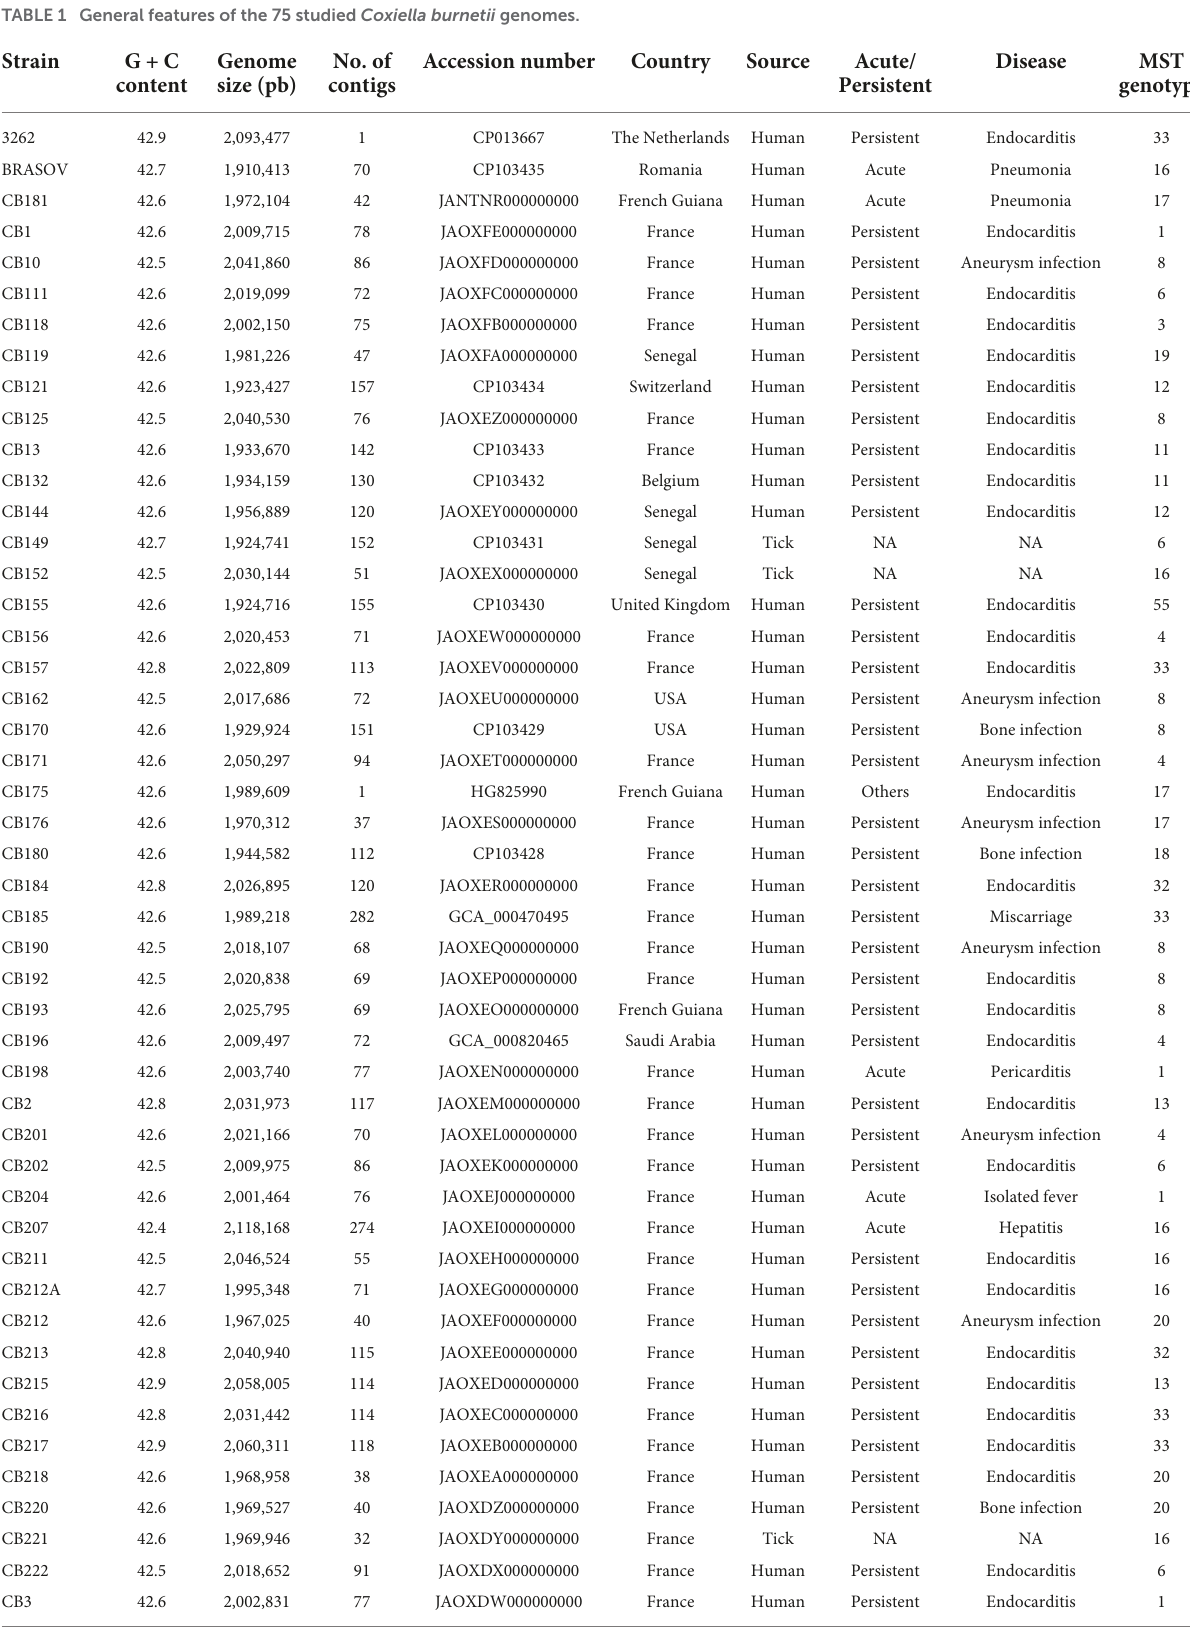
TABLE 1 General features of the 75 studied Coxiella burnetii